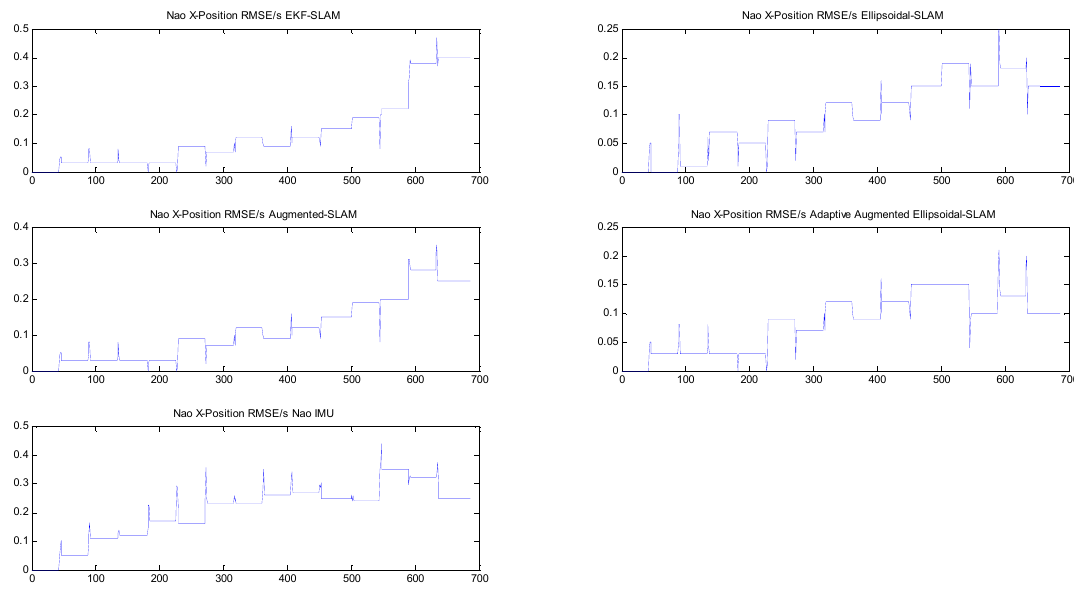
Figure 20. The root mean square (RMS) errors of NAO x-positions of the implemented SLAM.